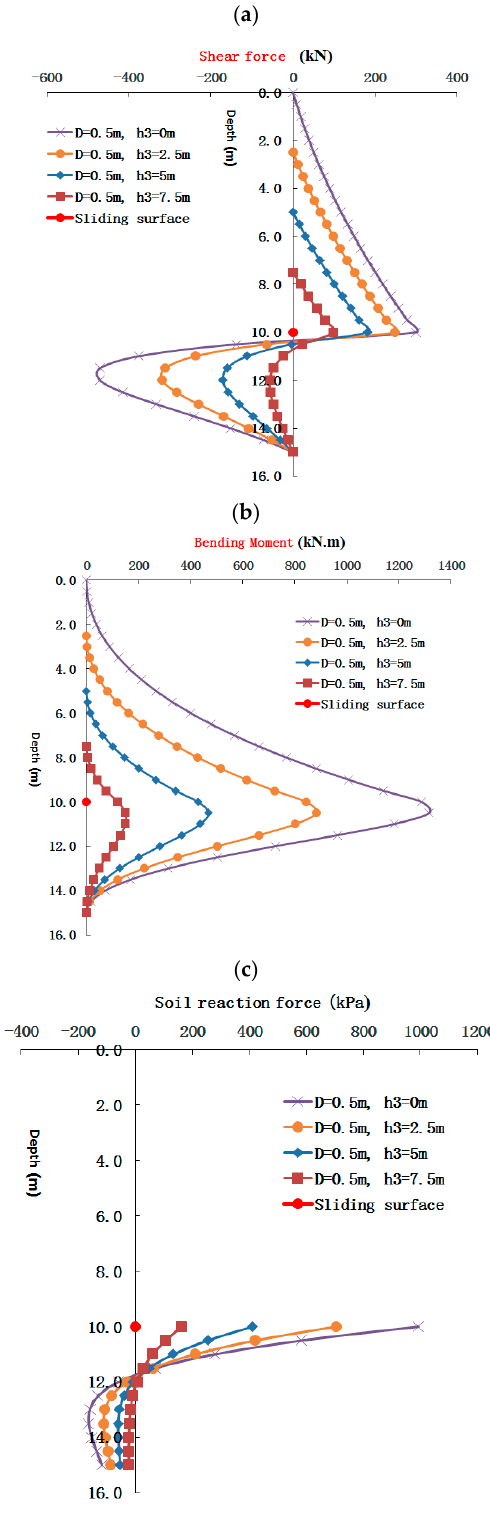
Figure 6. Calculated values of the internal forces for buried-boring piles of various buried depth with D = 0.5 m: ( a ) shear force; ( b ) bending moment; and ( c ) soil reaction force. The maximum internal force that can be withstood by the bored pile and the soil reaction force are the critical parameters for the failure of an anti-slide pile [23]. To study the variation of the soil reaction force and the maximum bending moment with buried depth, a sliding depth ratio, R L [38], was defined as the pile length above the slip surface, h , divided by the pile length, L , where L = h 4 +